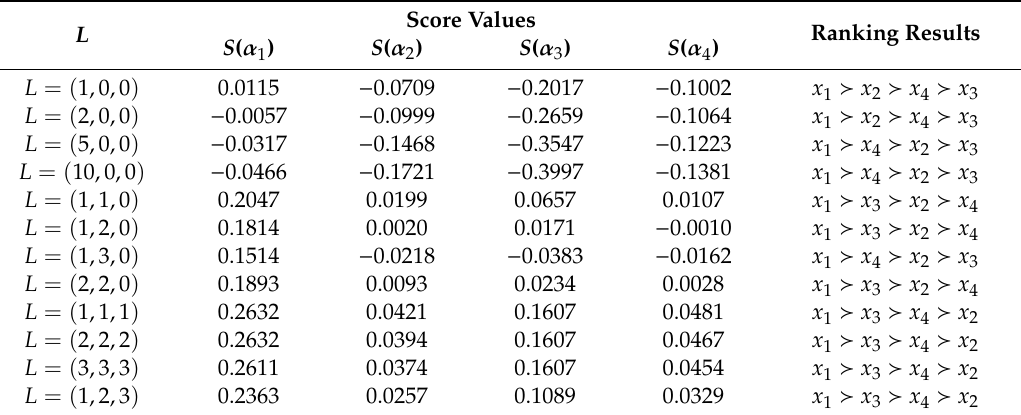
Ranking Results